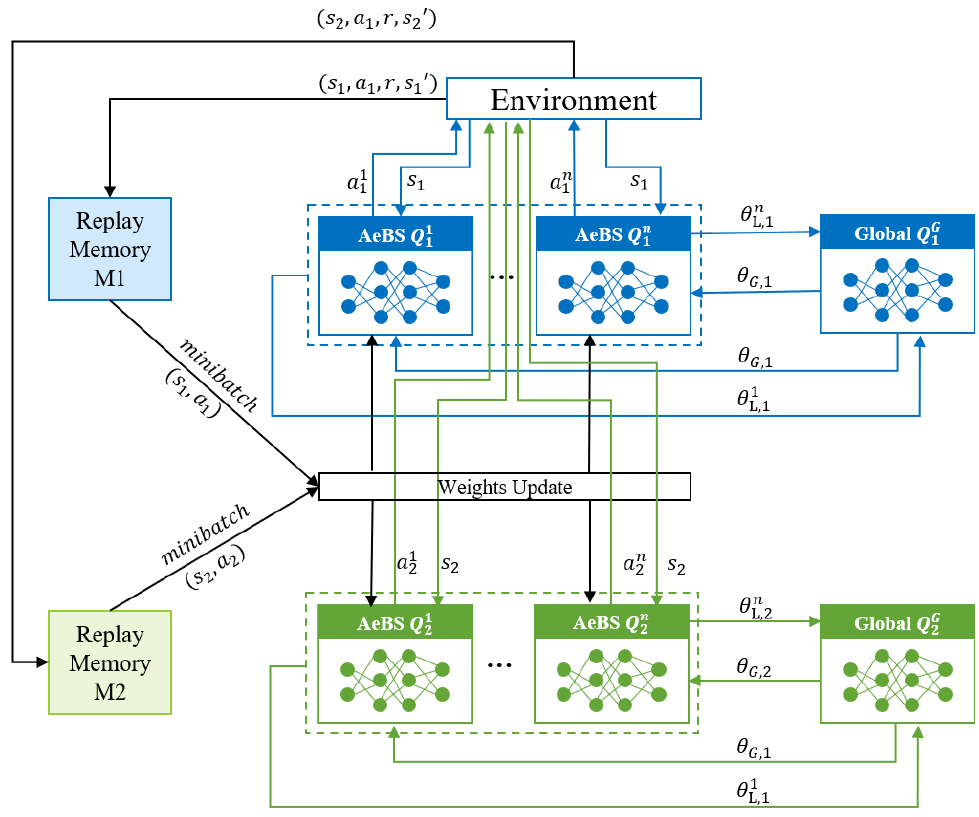
Figure 2. Flow chart of